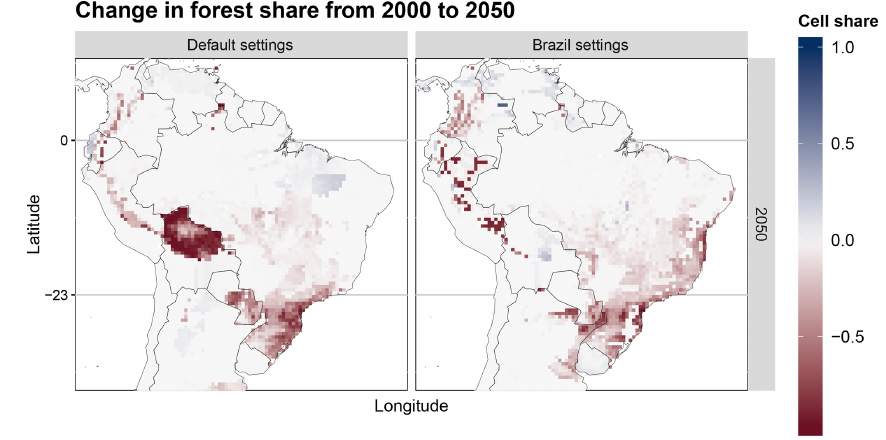
Figure 6. Comparison of changes in forest share from 2000 to 2050 in Brazil between the default setup and Brazil